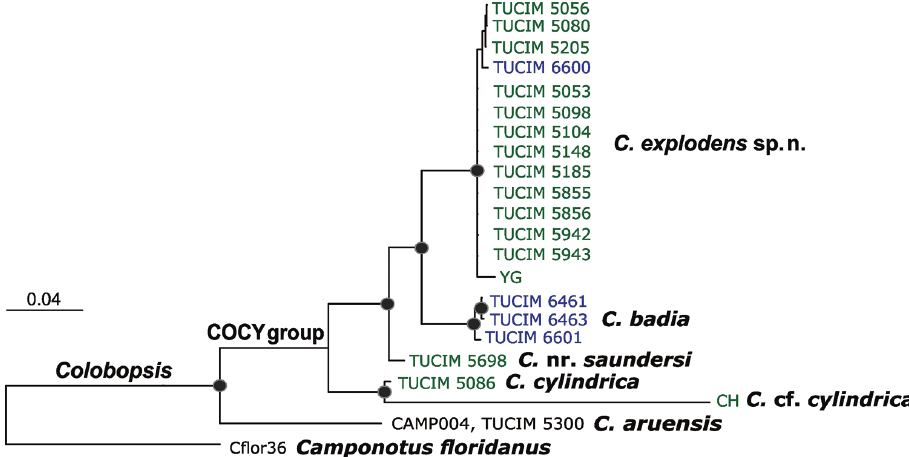
Figure 1. Bayesian consensus phylogram of C. explodens sp. n. and related taxa based on the concatenated alignments (2757 bp) of the three mitochondrial (COI, COII, cytB) and one nuclear (cad) phylogenetic markers. Nodes with posterior probabilities above 0.94 are marked with black dots. Specimens from Bor- neo are shown in green, from Thailand in blue. TUCIM 6463 corresponds to a male